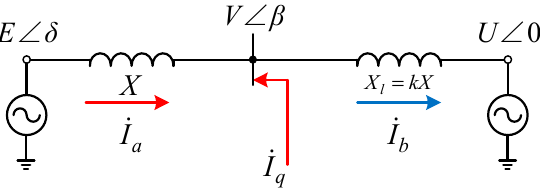
Appl. Sci. 2019 , 9 , x FOR PEER REVIEW Figure 3. Equivalent model on the electromechanical time scale. Figure 3. Equivalent model on the electromechanical time scale.